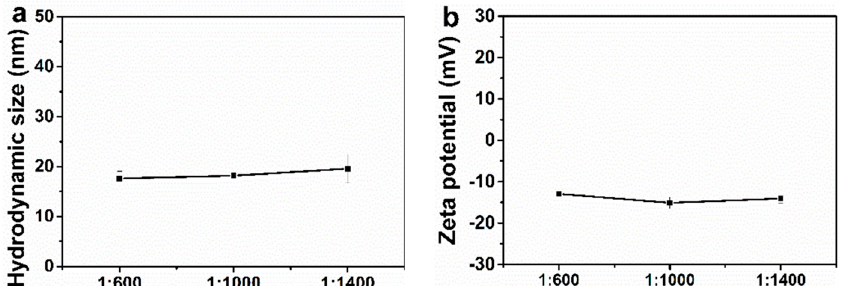
Figure 5. ( a ) The hydrodynamic size and ( b ) zeta potential of Pt n -GLP NCs in aqueous solution.